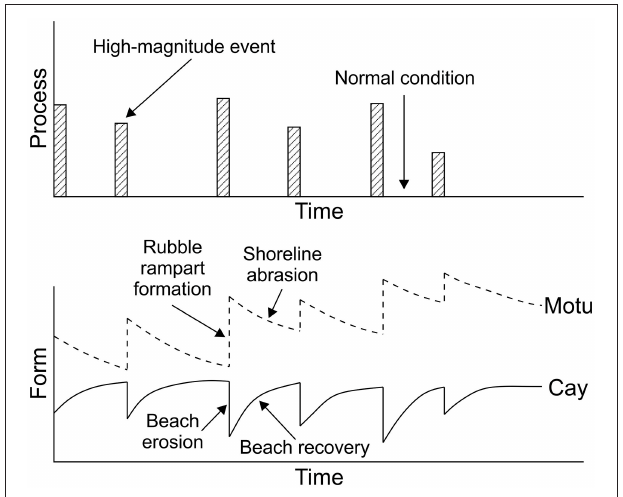
FIGURE 8 | The geomorphic response of motus and sand cays to the impact of storm events and re-adjustments in island form during interim low-energy conditions (Adopted from Bayliss-Smith (1988), reproduced with permission from John Wiley and Sons Inc.).